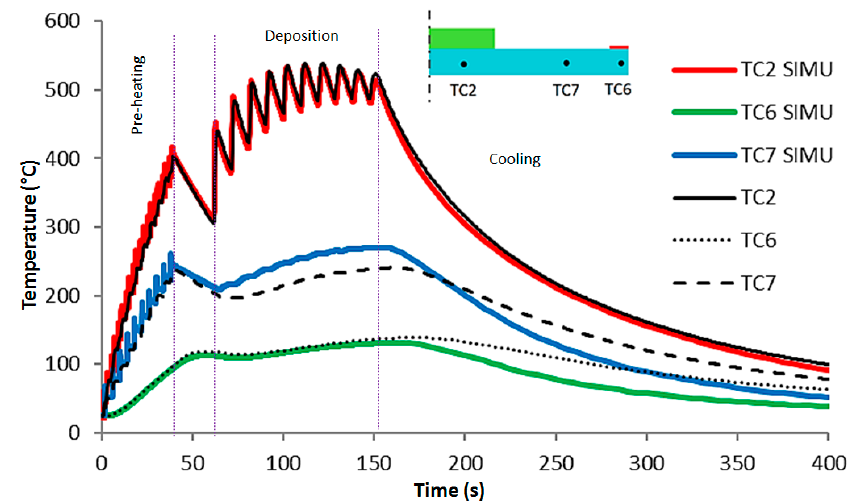
Figure 13. Validation of numerical results with thermal histories computed at the substrate Figure13. Validationofnumericalresultswiththermalhistoriescomputedatthesubstratethermocouple thermocouple points TC2, TC6, and TC7. points TC2, TC6, and